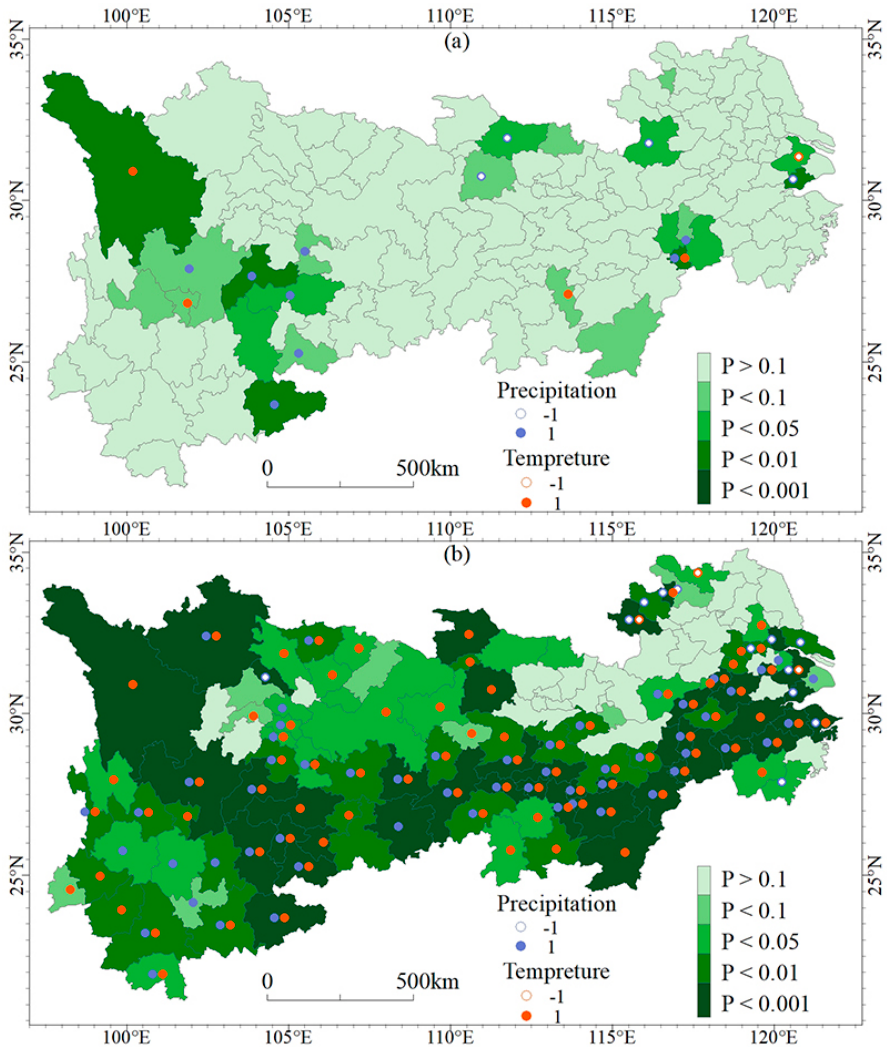
Figure 6. Confidence levels of the growing season NDVI prediction model with temperature and precipitation as predictors calibrated with the original annual data ( a ) and with the five-year smoothed data ( b ) from 2003 to 2019 (the circles and dots denote negative and positive correlations, respectively, with p < 0.1; red denotes the correlation between NDVI and temperature, and blue denotes precipitation).